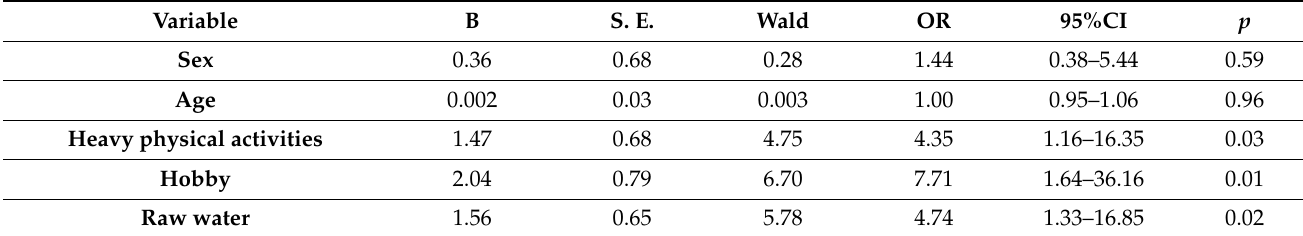
Table 3. Multivariate regression analysis of amyotrophic lateral sclerosis (ALS) risk factors. Variable